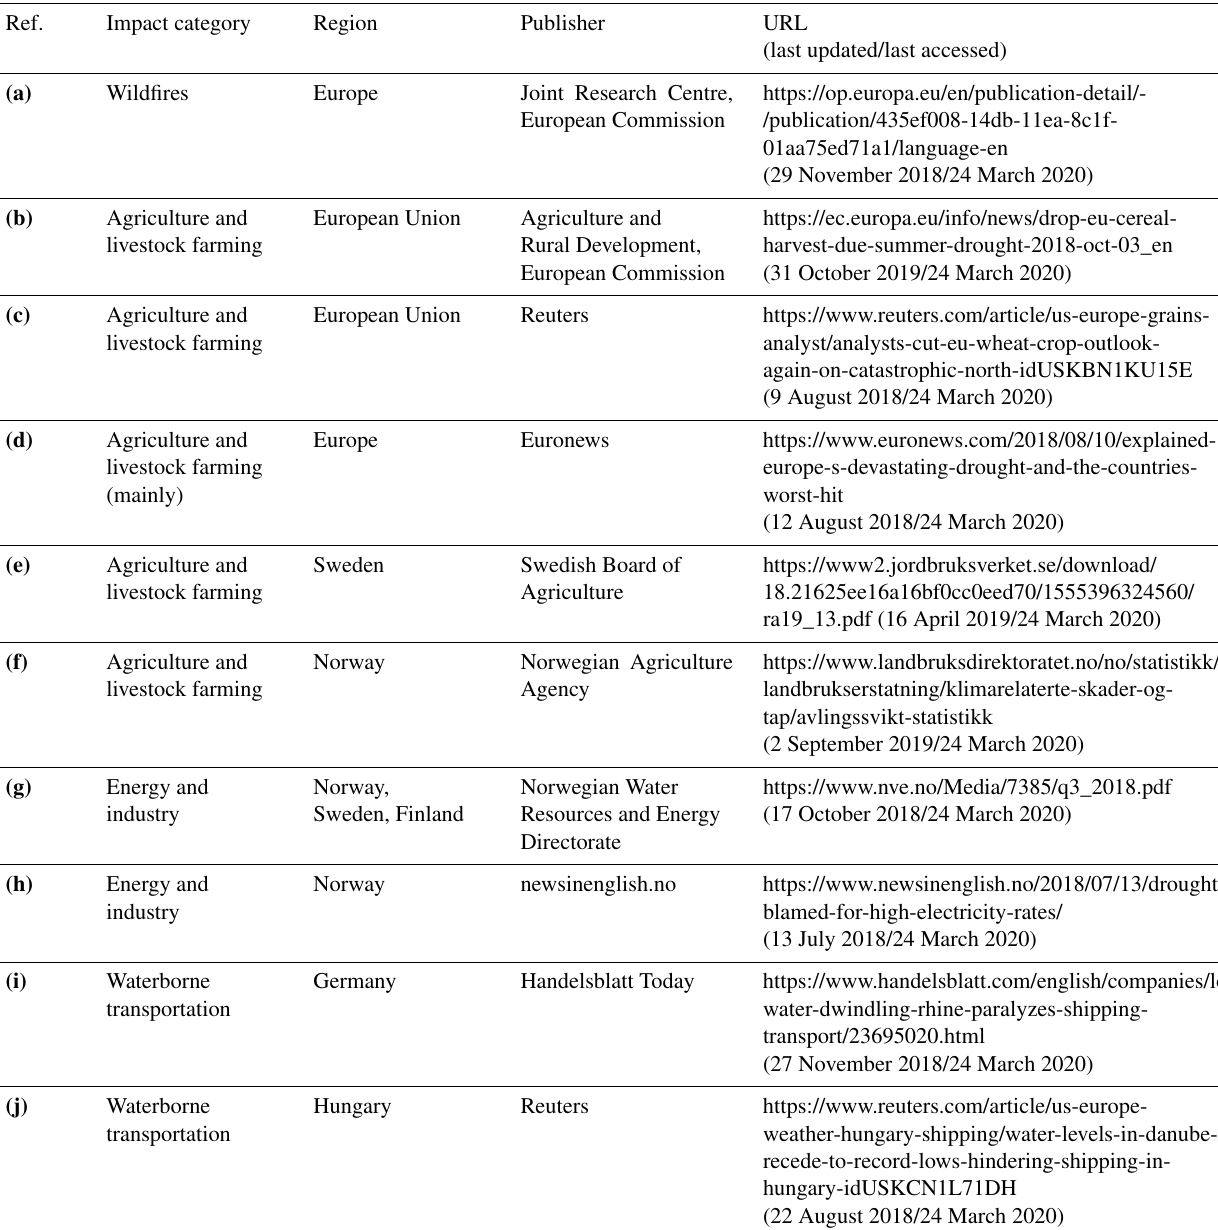
Table 1. Reports and news articles about 2018 heat- and drought-related impacts. The impact categories follow the European Drought Impact Report Inventory (EDII; Stahl et al.,